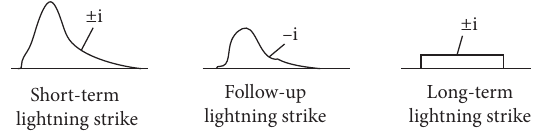
Figure 1: Three possible lightning strikes in a flash